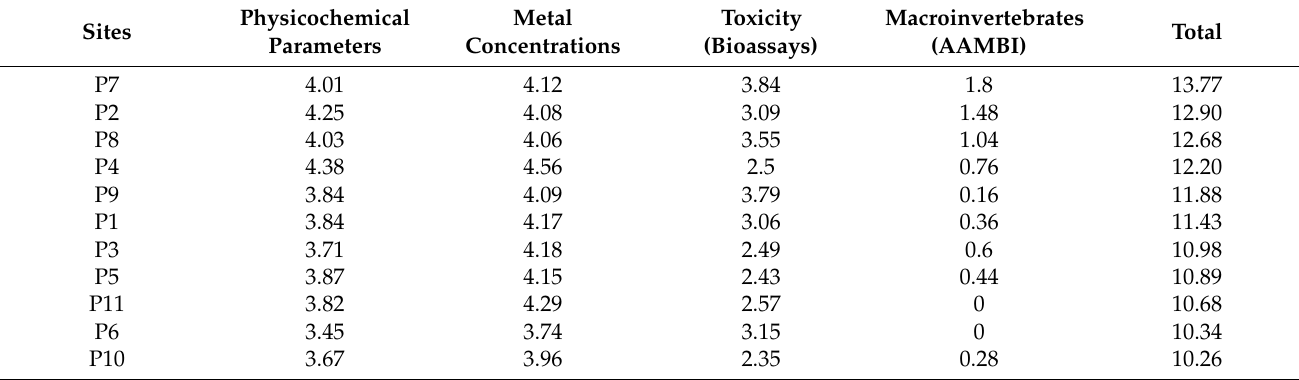
Table 2. Integrative matrix analysis of four LOEs: physicochemical parameters, metal concentrations, toxicity assessment with bioassays, and macroinvertebrate monitoring with the Andean–Amazon Biotic Index (AAMBI). Sites are ranked from low to high levels of environmental